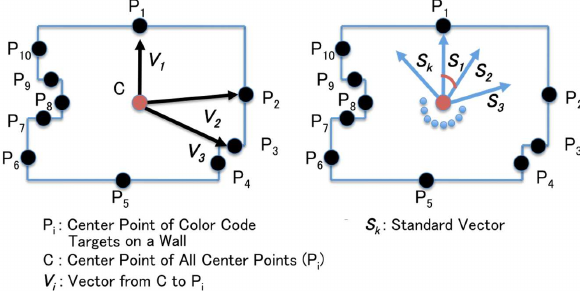
Figure 7. Determination of wall sequence order.